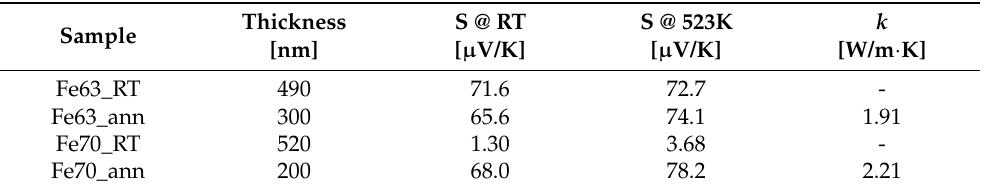
Table 2. Thickness, RT and high-T Seebeck coefficient and thermal conductivity of samples Fe63_RT, Fe63_ann, Fe70_RT and